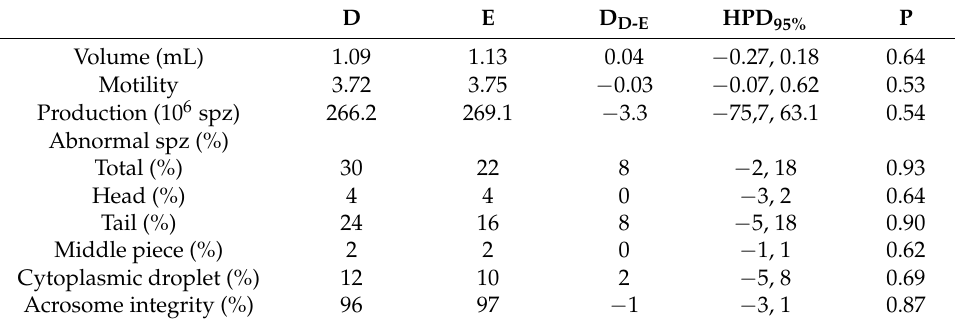
Table 2. Effect of diet on sperm quality in male rabbits .